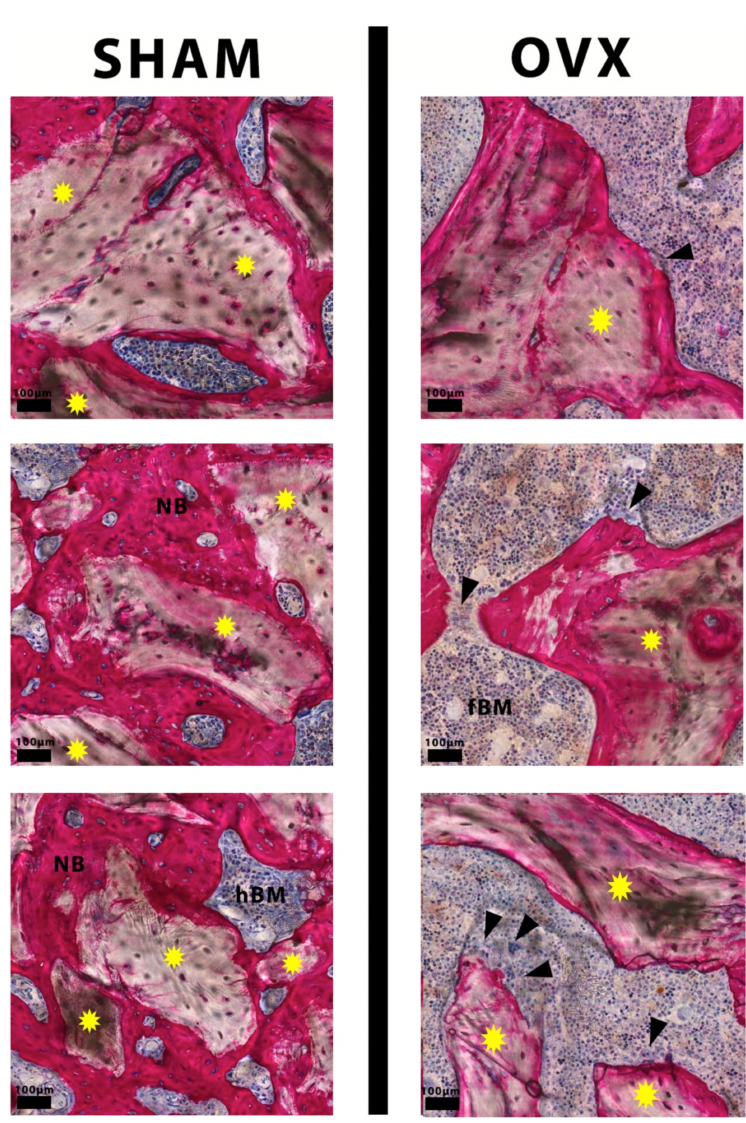
Figure 5. Representative histological images at higher magnification showing InterOss ® granules (yellow stars) well integrated and completely covered with newly formed bone (NB) in SHAM rats ( left ). In OVX rats, eroded bone surface and osteoclast-like cells (black arrowheads) were present ( right ). Bone marrow-like tissue in OVX rats contained more fat cells (fBM) compared to the hypercellular bone marrow-like tissue (hBM) in the SHAM